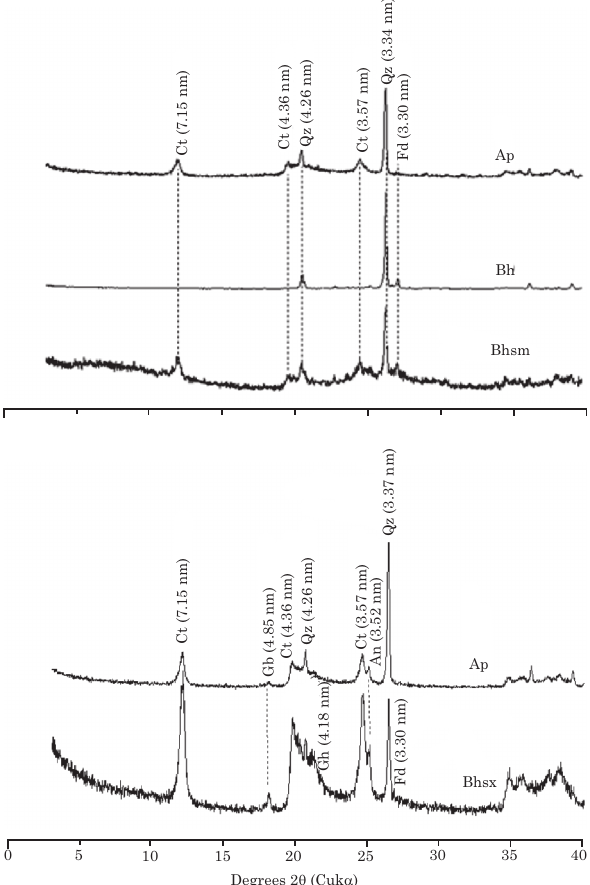
Figura 3. Difratogramas de raios-X da fração silte dos horizontes Ap, Bh e Bhsm, do perfil 1, e dos horizontes Ap e Bhsx, do perfil 6. Ct: caulinita; Fd: feldspato; Qz: quartzo; Gb: gibbsita; e Gh: